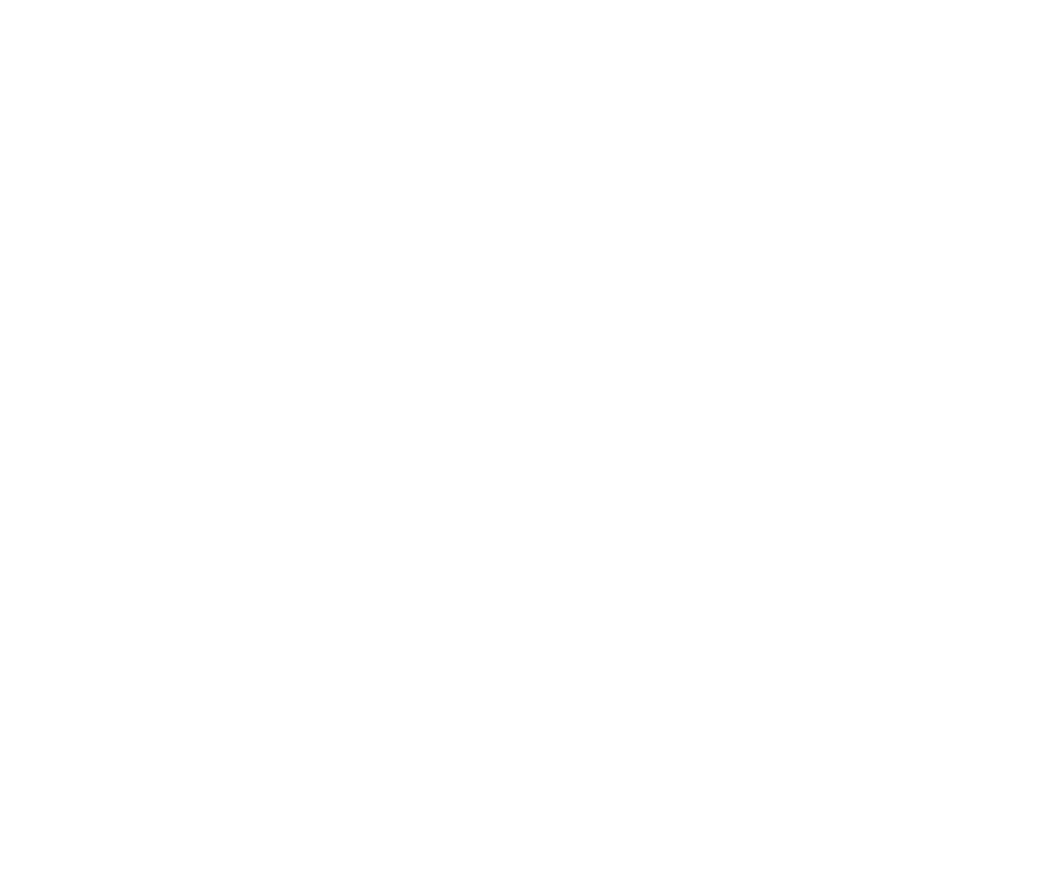
Figure 6 Types of dietary supplements assessed in Cochrane